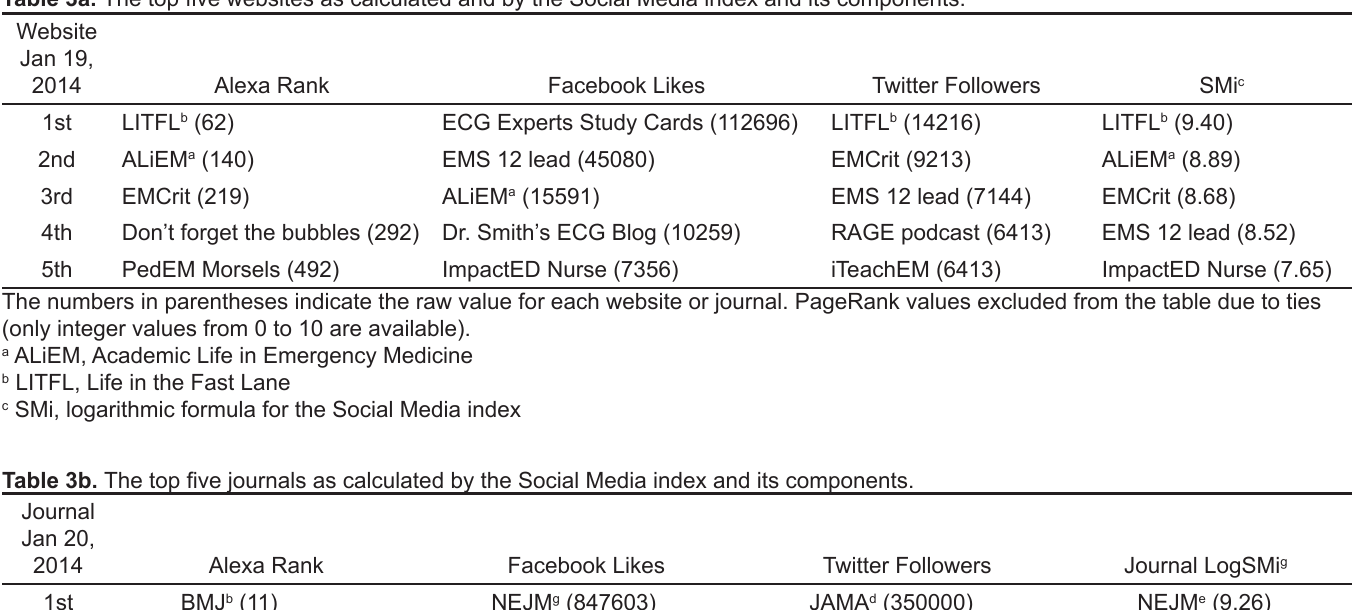
Table 3a. The top five websites as calculated and by the Social Media index and its components.